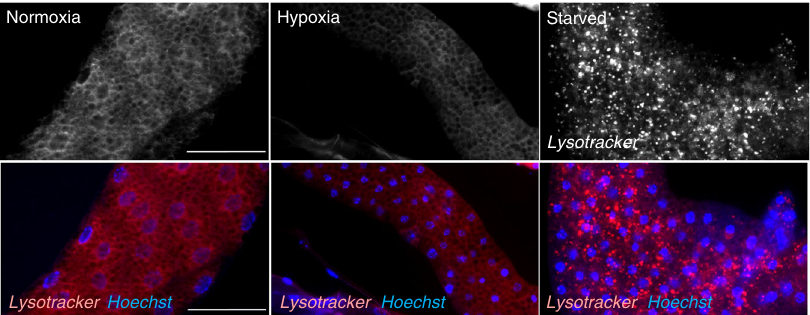
Fig. 5 Hypoxia does not induce autophagy. Early third instar larvae were maintained in normoxia (left panels), transferred to hypoxia for 6 h (middle panels), or starved on PBS for 6 h (right panels). Fat bodies were then dissected, stained with LysoTracker and then imaged. Red = LysoTracker; blue = Hoechst DNA stain. Scale bar = 50 μ m. Starvation, but not hypoxia, induced autophagy in the fat body. For each condition, fat bodies were dissected from at least fi fteen independent larvae. The images are representative lysotracker staining from each condition. We observed essentially no LysoTracker Red stained punctae in either the fed or hypoxic fat bodies, but all the starved fat bodies showed pronounced staining similar to that seen in the representative image in this fi